Question: In a single sentence, describe what this figure presents.
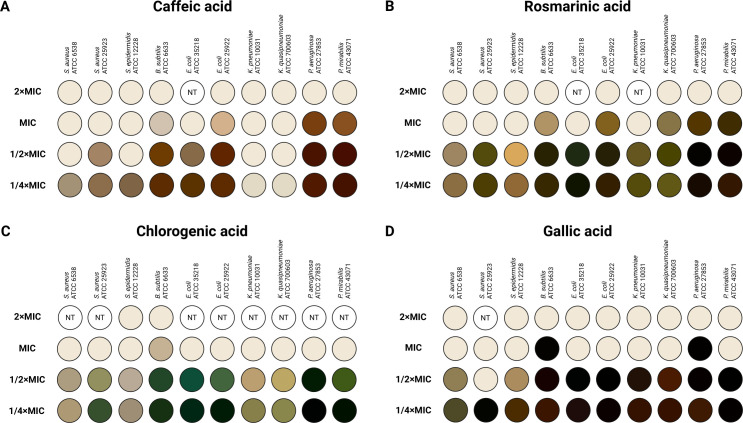
Answer: The color of wells after the MIC assay. ( A ) Treated with caffeic acid; ( B ) treated with rosmarinic acid; ( C ) treated with chlorogenic acid; ( D ) treated with gallic acid. MIC—minimum inhibitory concentration; NT—not tested. Created in BioRender. Bārzdiņa, A. (2026) https://BioRender.com/63zn8yk .